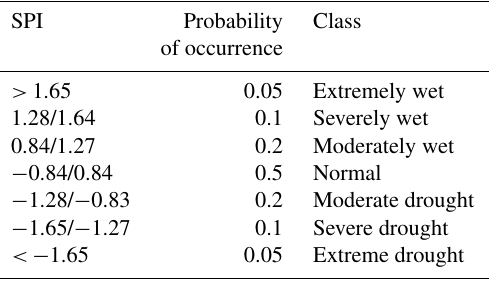
Table 3. Standardized Precipitation Index (SPI) categorisation and associated probability of occurrence (Agnew